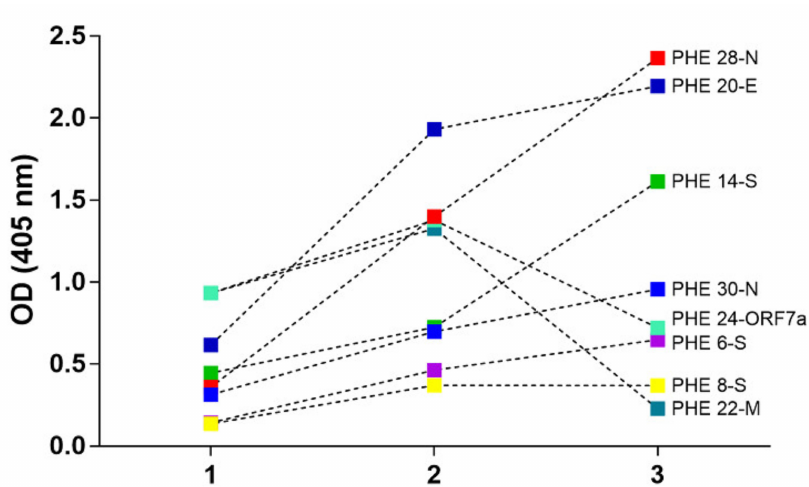
Figure 5. Evidence of a long-lasting humoral immunity for specific SARS-CoV-2 epitope-peptides. Patients − some cases of study became evident. A representative case study reveals an interesting immune-reactivity pattern by all di ff erent tested epitope-peptides representative of gene expression products S, E, M, N, 3a and 7a, respectively, in a follow-up between 1 month (lane 2) and 5 months (lane 3) after becoming infected with the SARS-Cov-2. Lane 1 represents the average of negative